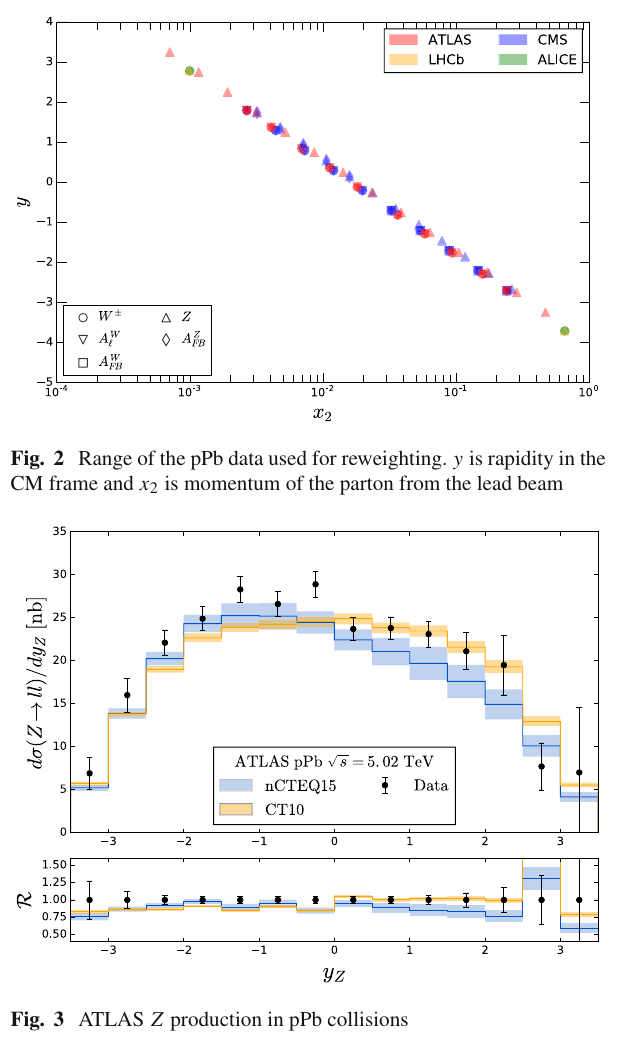
Fig. 5 LHCb Z production in pPb